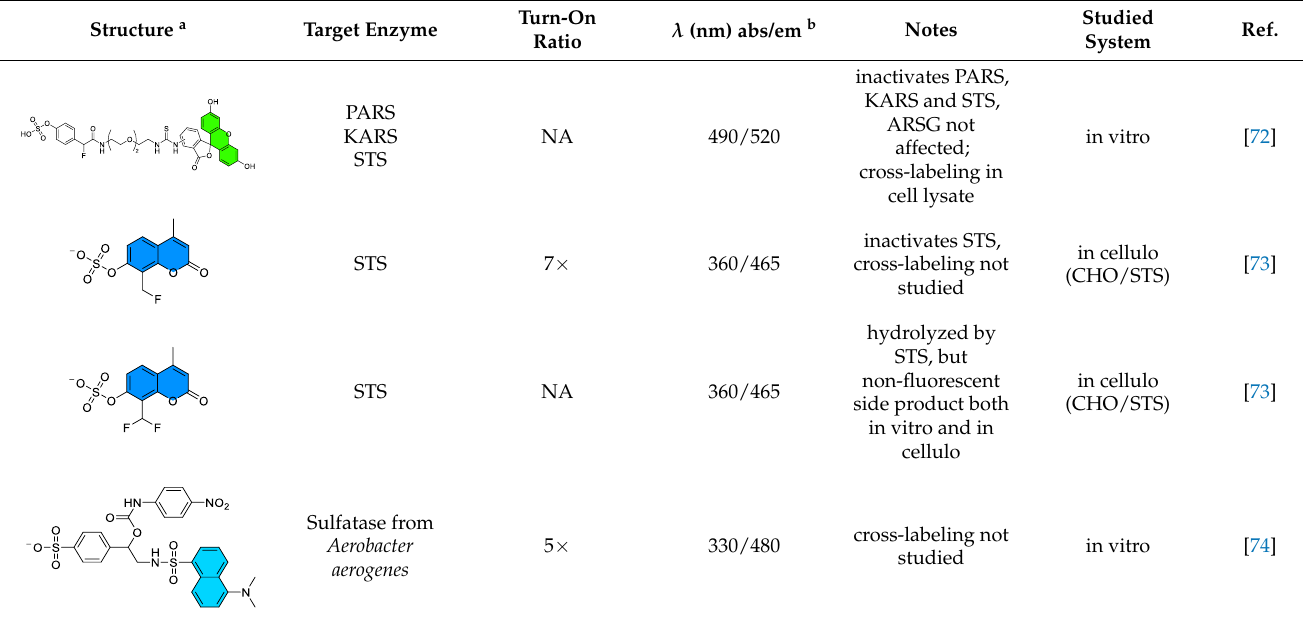
Figure 17. ( a ) Activation of probes 1 – 4 by sulfatase activity. ( b ) Inhibition of the four sulfatases (white: without inhibitor, grey: 1 mM inhibitor, black: 3 mM inhibitor). Reproduced with permission from [72], copyright 2012 Elsevier . Table 8. Activity-based probes for different Table 8. Activity-based probes for different sulfatases. Table 8. Activity-based probes for different sulfatases. Table 8. Activity-based probes for different sulfatases.